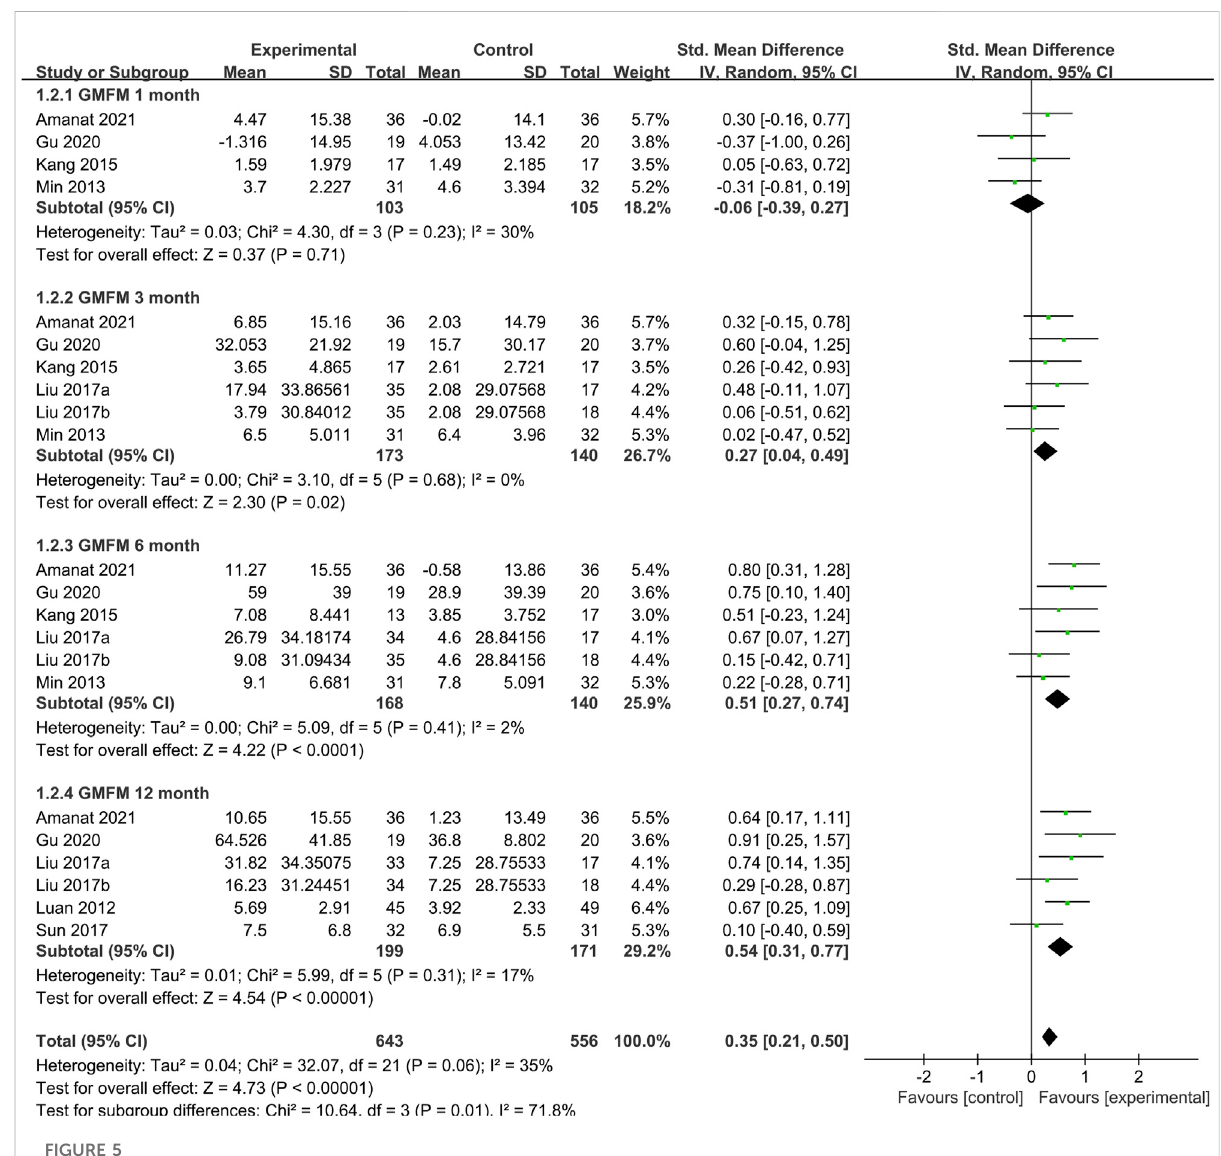
Time subgroup of